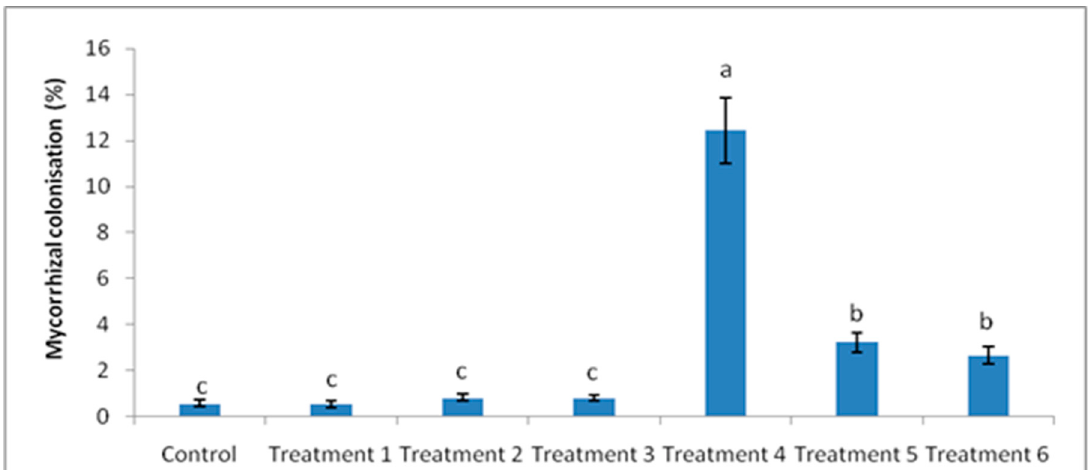
Figure 4. Effect of biochar, fertilizer and manure on percent of arbuscular mycorrhizal (AM) colonization in roots of cucumber. Different letters above the bars suggested that these values are significantly different at p ≤ 0.05.